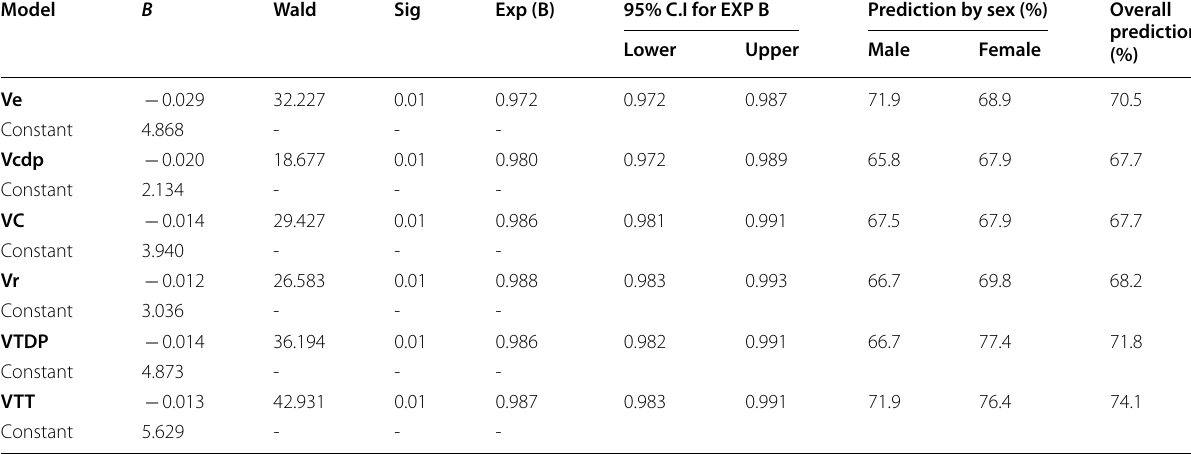
Note: The odd cut value is 0.5, considering above this value is female and below is male. B coefficient for the constant, Wald Wald chi-square value, Sig exponentiation of the B coefficient, Ve volume of enamel, Vcdp volume of coronal dentine and pulp, VC total crown volume, Vr volume of root), VTDP total dentine